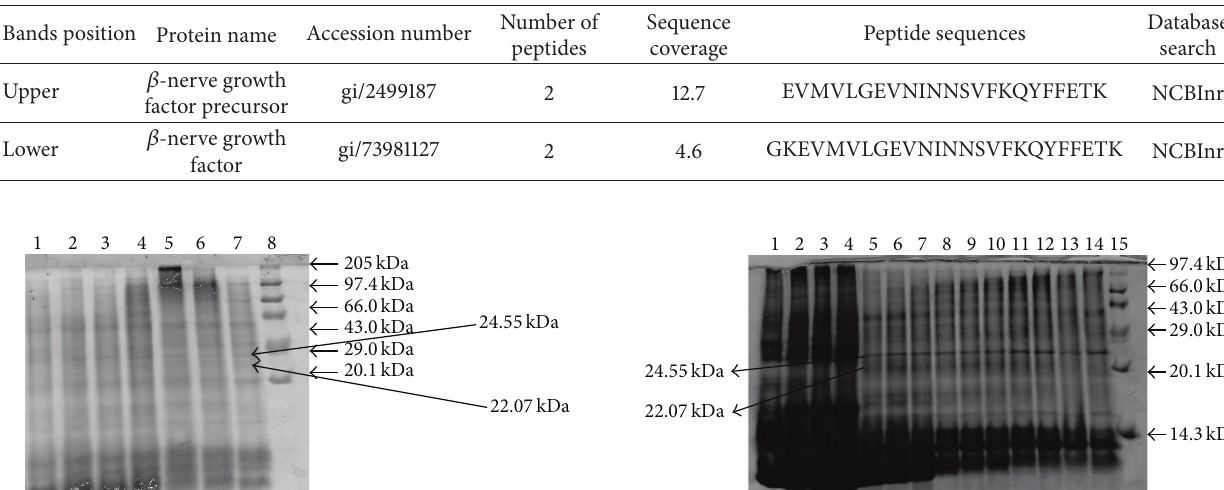
Table 1: Proteins identified in dromedary seminal plasma by MALDI-TOF/MS of the 24.55 and 22.07 kDa bands.